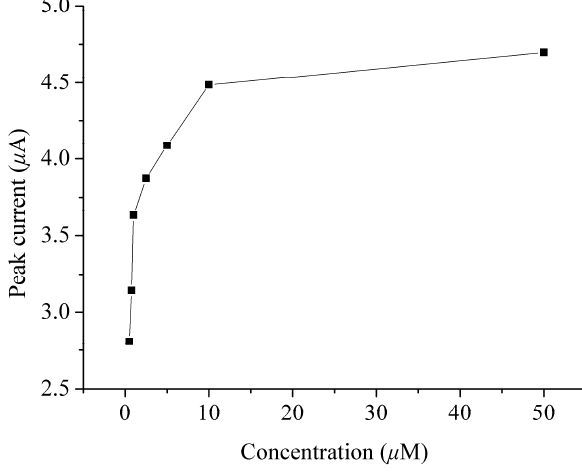
Figure 2. Relationship between the oxidation peak current of hIAPP and its